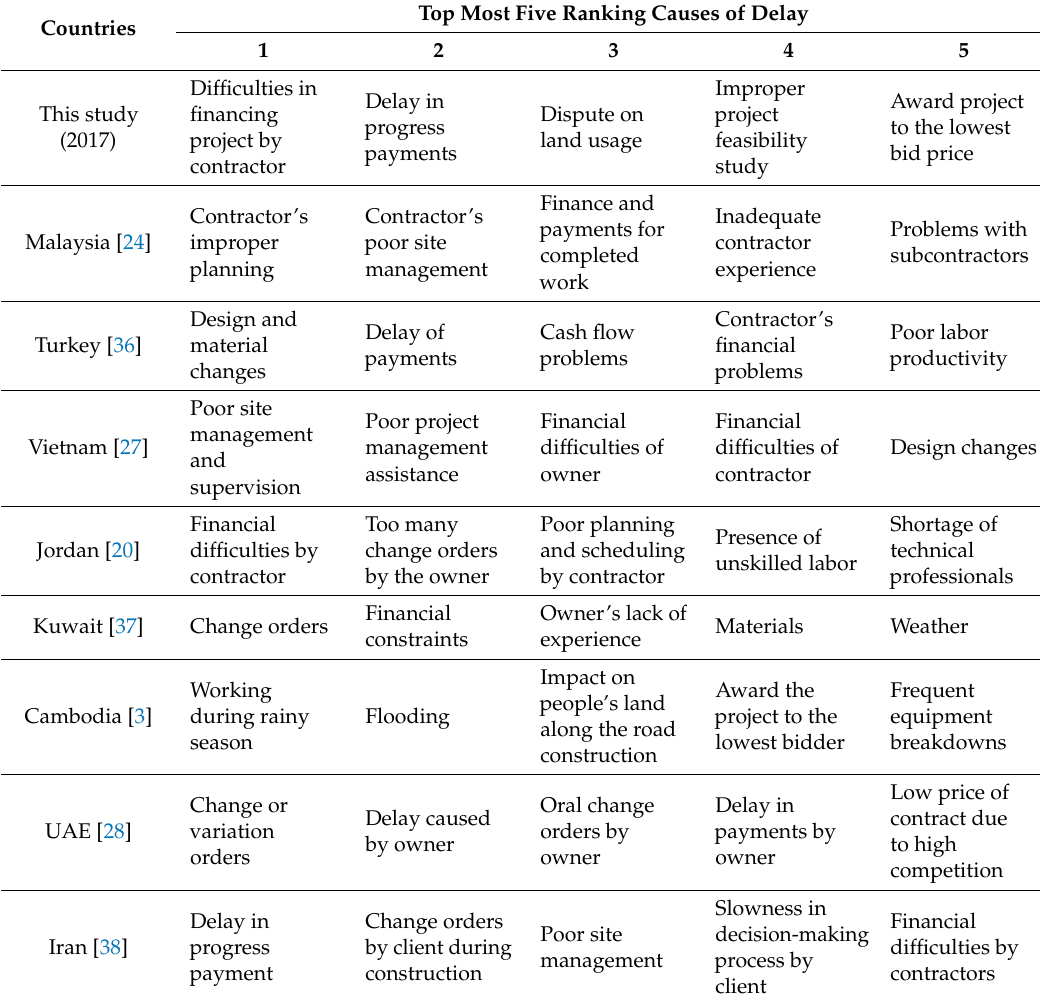
Table 5. Comparison with Eight Selected Asian